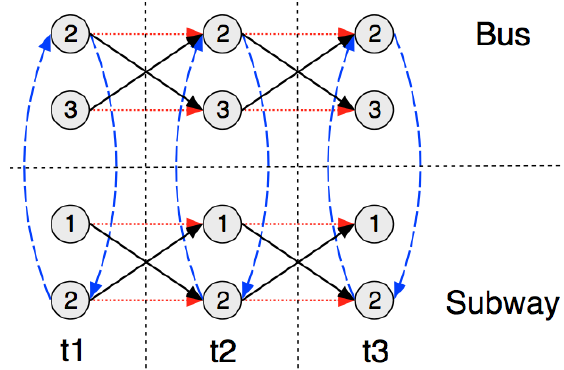
Figure 4. m p T q of the example MAG T